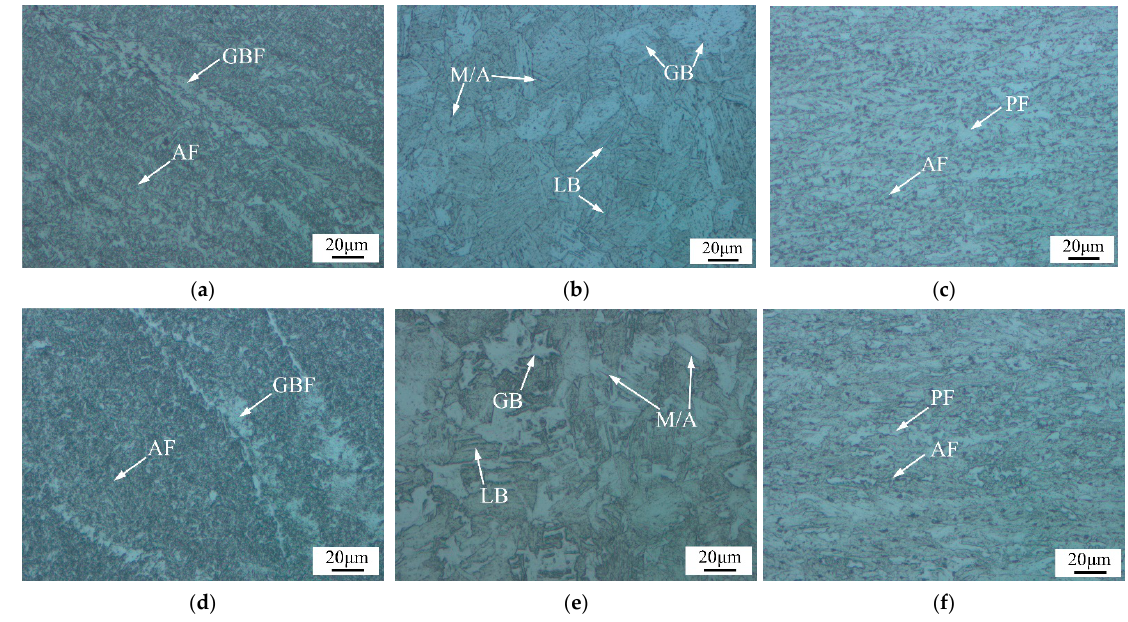
Figure 3. The microstructure obtained from the welded and heat-treated joints: ( a ) the center of the welded joint; ( b ) FGHAZ of welded joint; ( c ) SCHAZ of welded joint; ( d ) the center of the heat-treated joint; ( e ) FGHAZ of heat-treated joint; and ( f ) SCHAZ of heat-treated joint. The CGHAZ directly affected the overall performance of the welded joint, and its